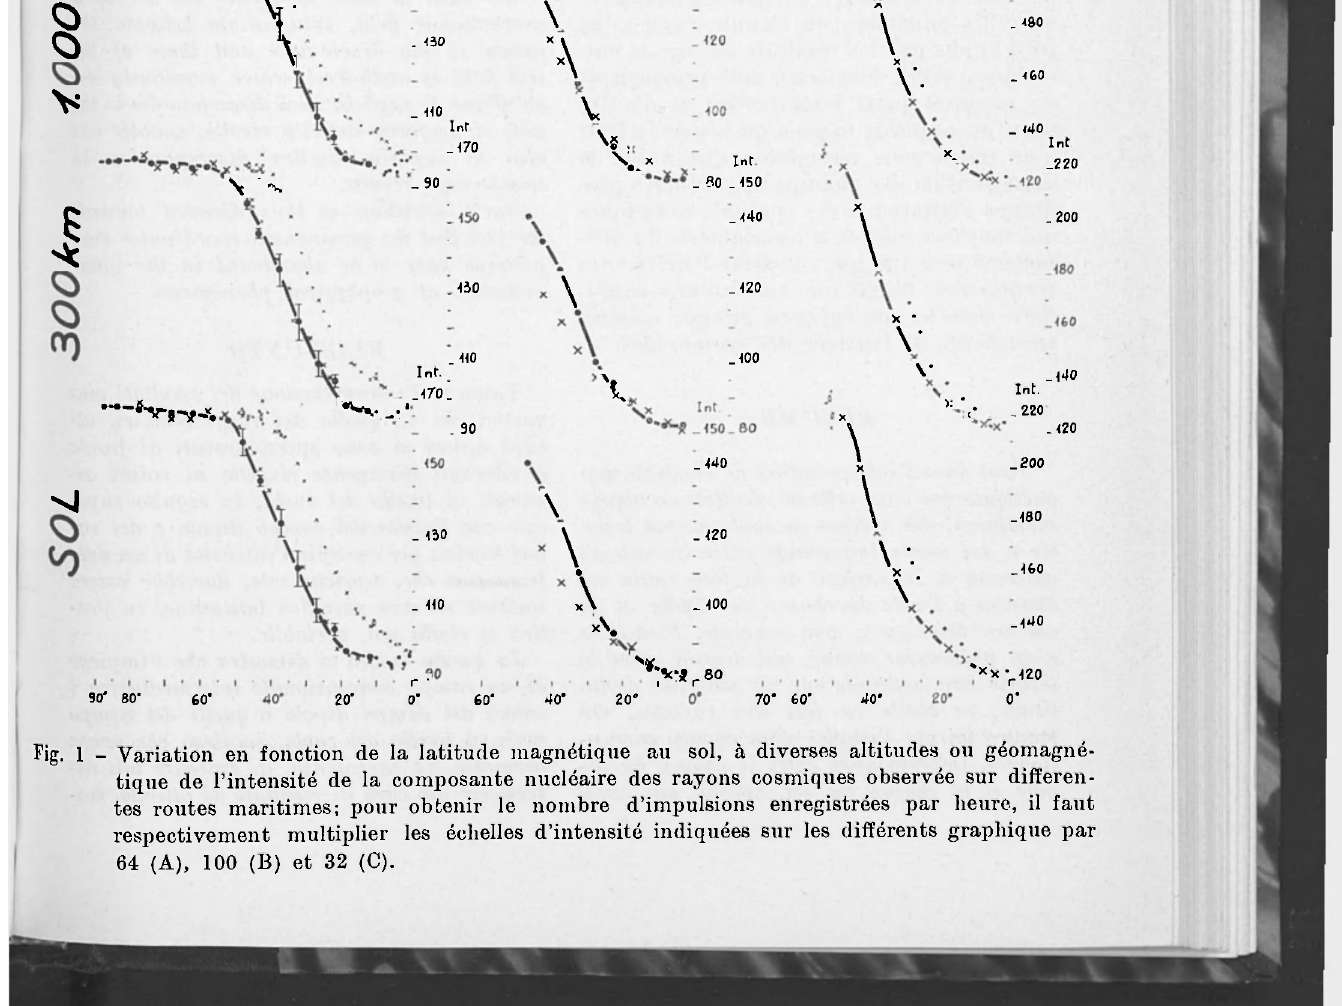
Fig. 1 - Variation en fonction de la latitude magnétique au sol, à diverses altitudes ou géomagné- tique de l'intensité de la composante nucléaire des rayons cosmiques observée sur differen- tes routes maritimes; pour obtenir le nombre d'impulsions enregistrées par heure, il faut respectivement multiplier les éehelles d'intensité indiquées sur les difiérents graphique par 64 (A), 100 (B) et 32